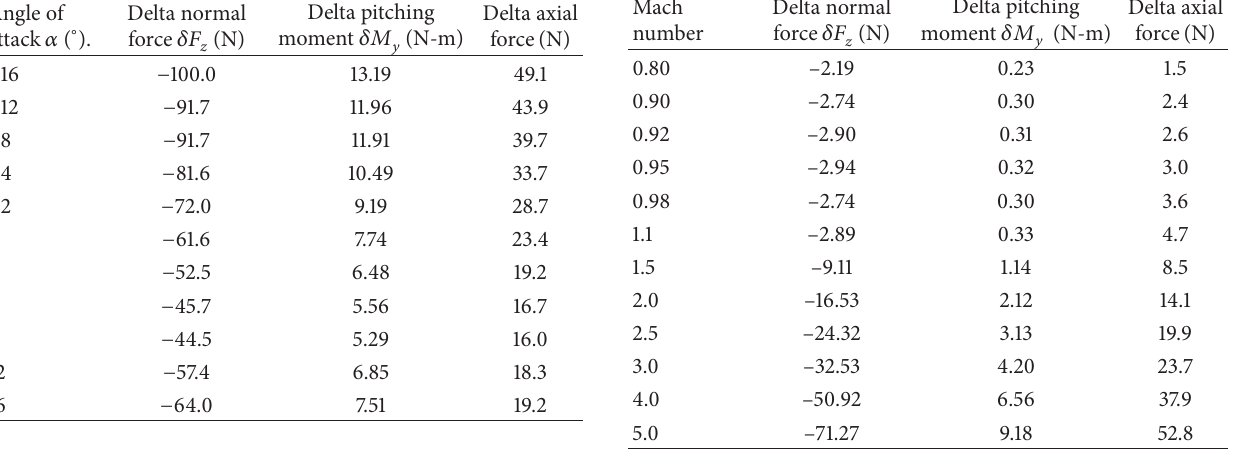
Table 6: Variation of delta forces and moments due to microflaps with angle of attack, 𝑀 = 2.5. Angle of attack 𝛼 ( ∘ ).